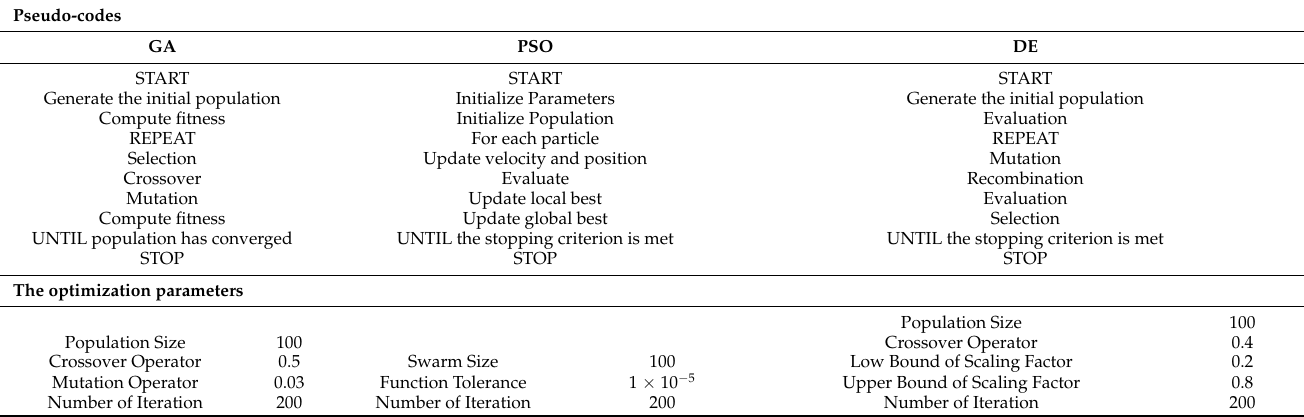
Table 1. Optimization pseudo-codes and the optimization